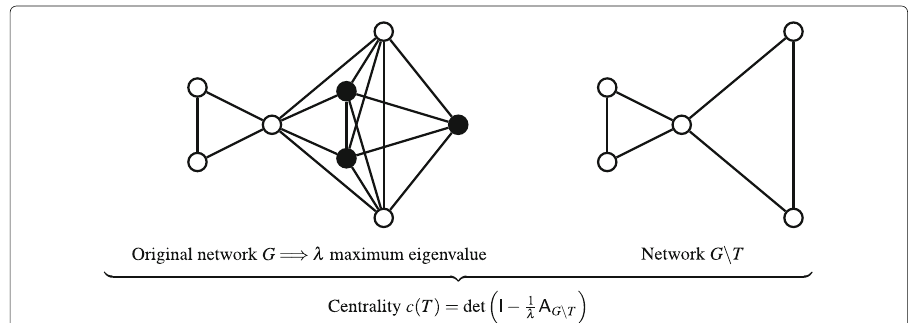
Fig. 1 Schematic representation of the calculation of a centrality. Left : full network G , with in black the group of three vertices forming a triangle T , the centrality of which is desired. Right: graph G \ T where all vertices belonging to T have been removed. The matrix A G \ T is the adjacency matrix of G \